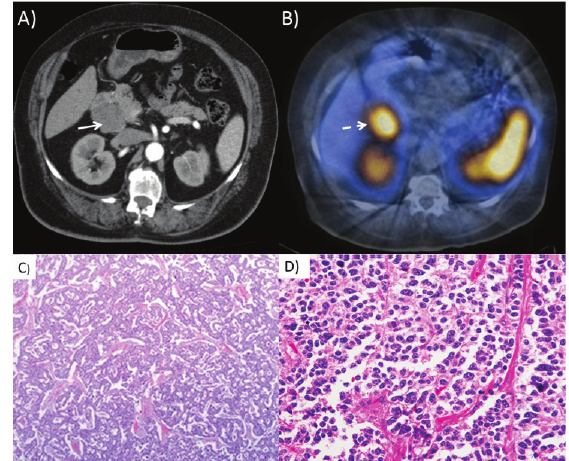
Figure 4. (A) Axial CT images of the abdomen with contrast show a mass in the head of the pancreas (white arrow) in a patient with abnormal gastrin levels clinically. (B) SPECT-CT images of a patient after administration of In-111-octreoscan show abnormal uptake in the pancreatic head mass (dashed white arrow). (C) Low-power- and (D) high-power- hematoxylin-eosin staining showing uniform neuroendocrine